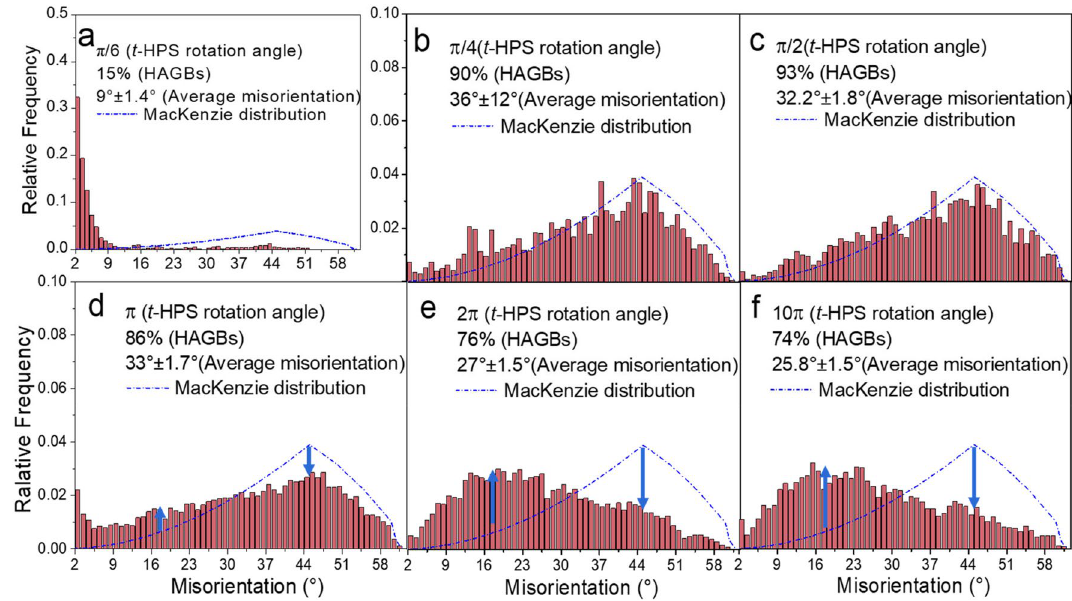
Figure 5. Evolution of grain boundary misorientation distributions upon increase of t -HPS rotation angle through ( a ) π/6, ( b ) π/4, ( c ) π/2, ( d ) π, ( e ) 2π and ( f ) 10π. It is important to note the different range of the vertical axis in ( a ).